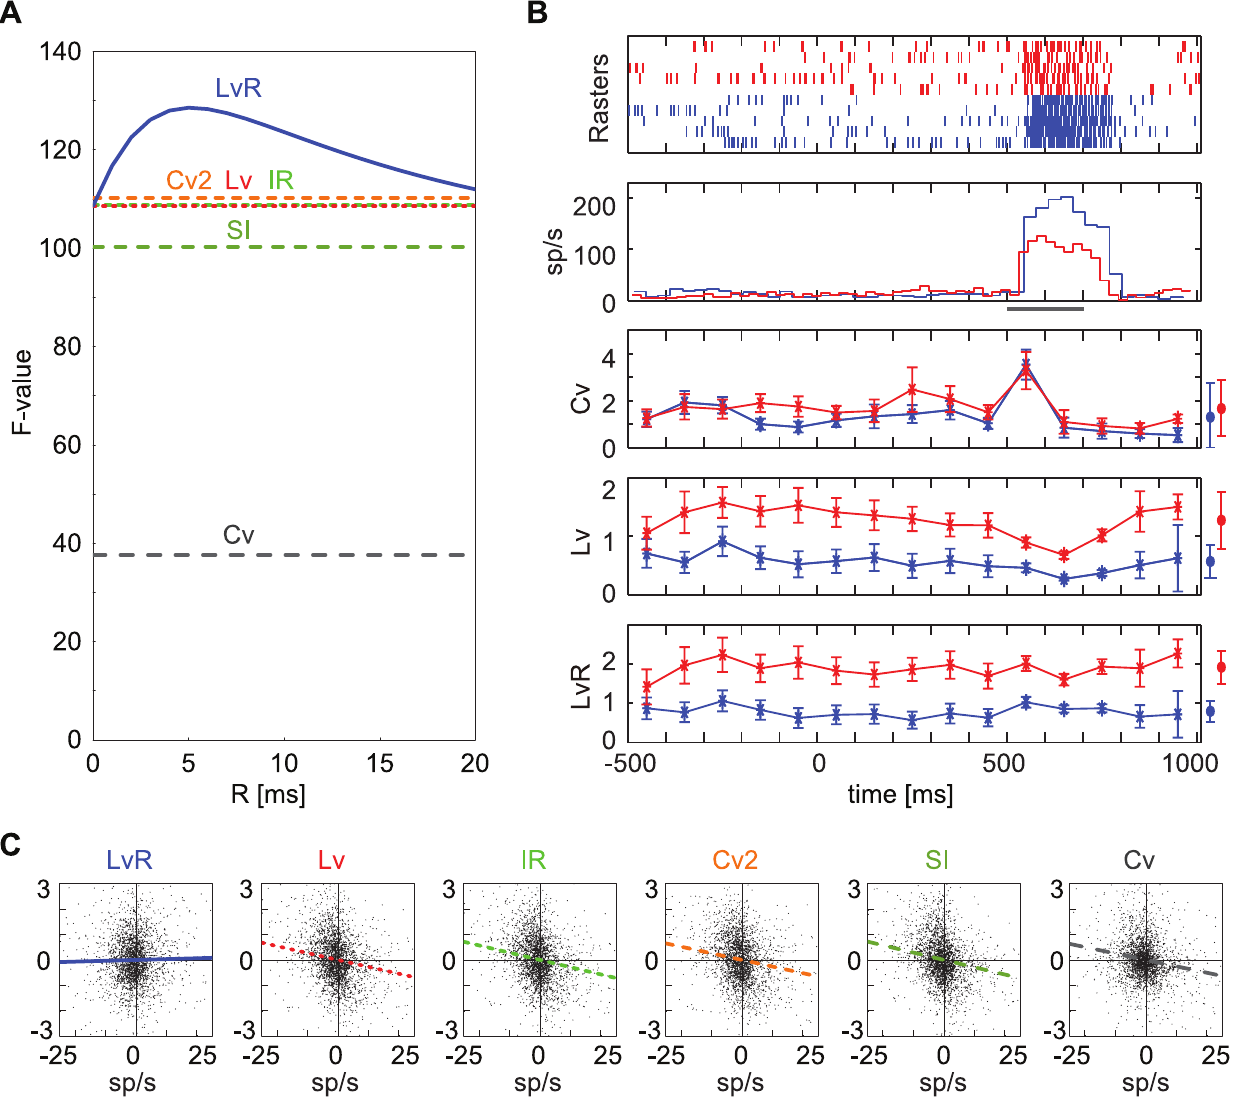
Figure 2. Performance of LvR and other firing irregularity metrics. (A) Dependence of LvR on the refractoriness constant, R . Ordinate, performance of LvR estimated as the F -value of ANOVA for the entire 1,307 neurons. (B) Peristimulus spike rasters and histograms for two MT neurons during a stimulus with textured image motion from 500–700 ms (thick horizontal bar) [47]. The spike rasters were aligned to the onset of a fixation target (the origin of the abscissa) upon which the monkey was required to fixate. The perievent metrics Cv , Lv and LvR were determined for spike rasters sampled in time windows of 6 50 ms around the time of each bin. Error bars indicate the confidence level (p , 0.05, t-distribution). (C) Scatter plots of the six metrics plotted against fluctuation in the firing rate across 20 ISI segments from the 1,307 neurons. The ordinate and abscissa represent the deviations of the metric and the firing rate from the means, normalized to SD, respectively. Colored lines represent average slopes.